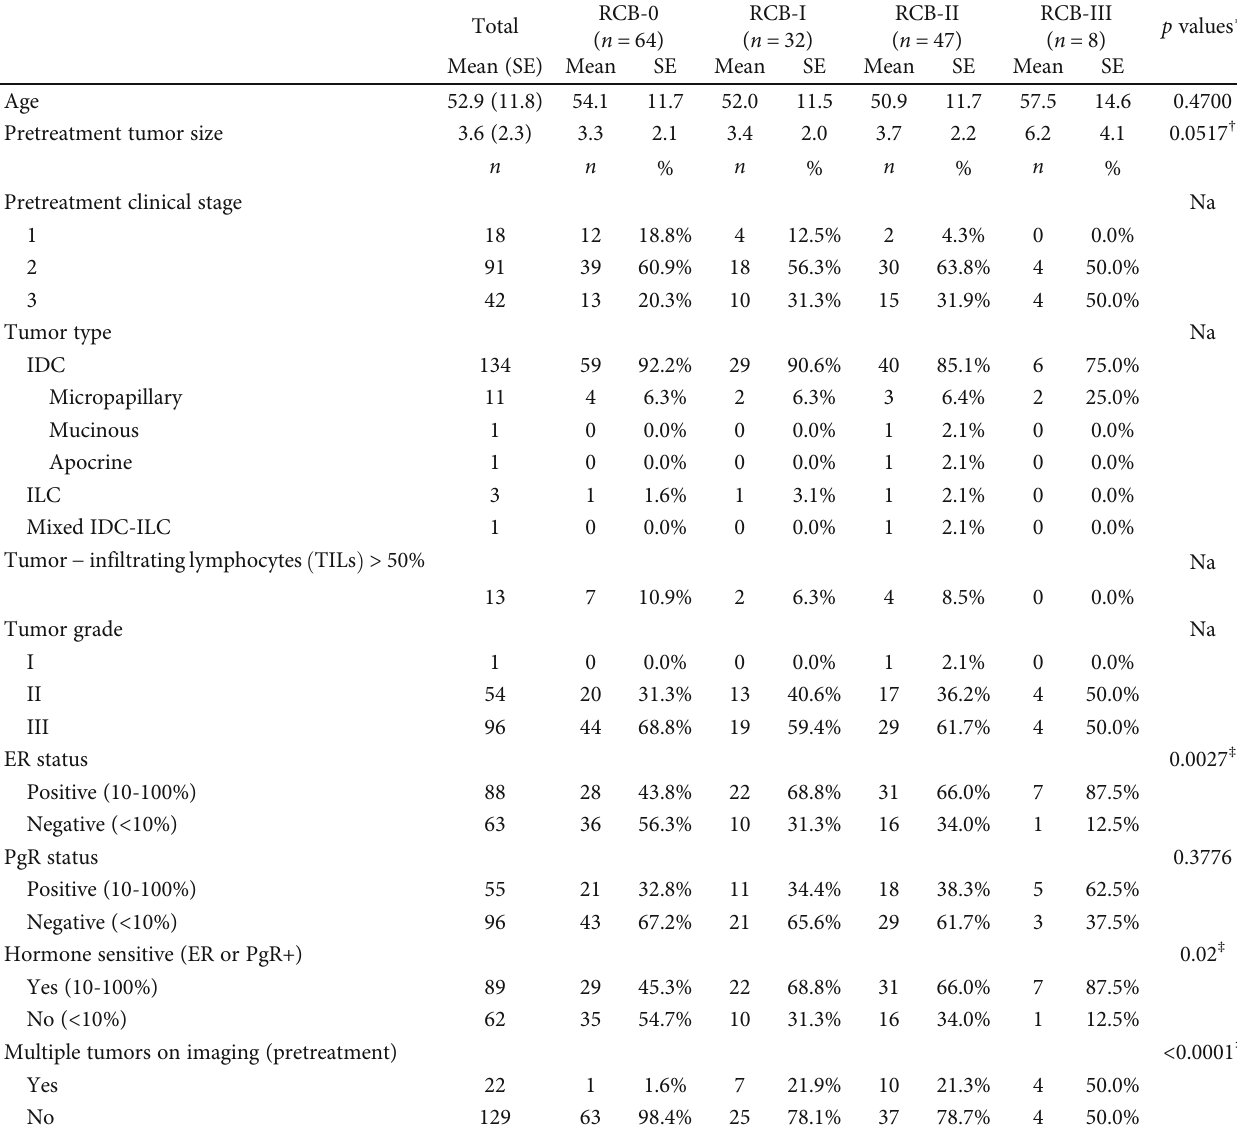
Table 2: Characteristics of patients with HER2+ breast cancer receiving neoadjuvant chemotherapy: evaluation of residual cancer burden in 151